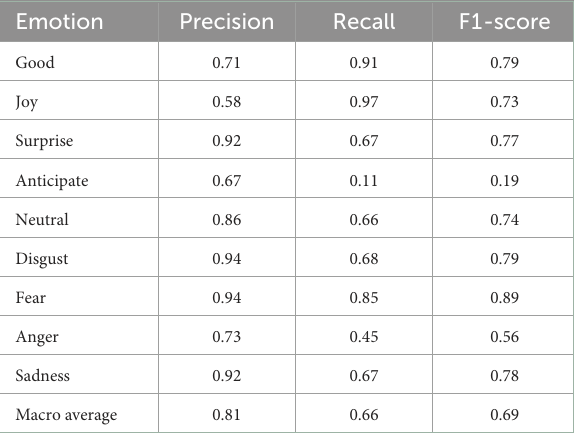
TABLE 2 Performance metrics of the algorithm in terms of emotion